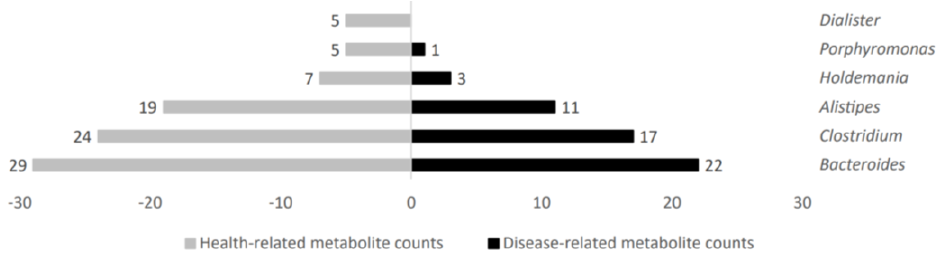
Figure 5. Health − related metabolite counts stratified according to gut microbiota taxa producers.